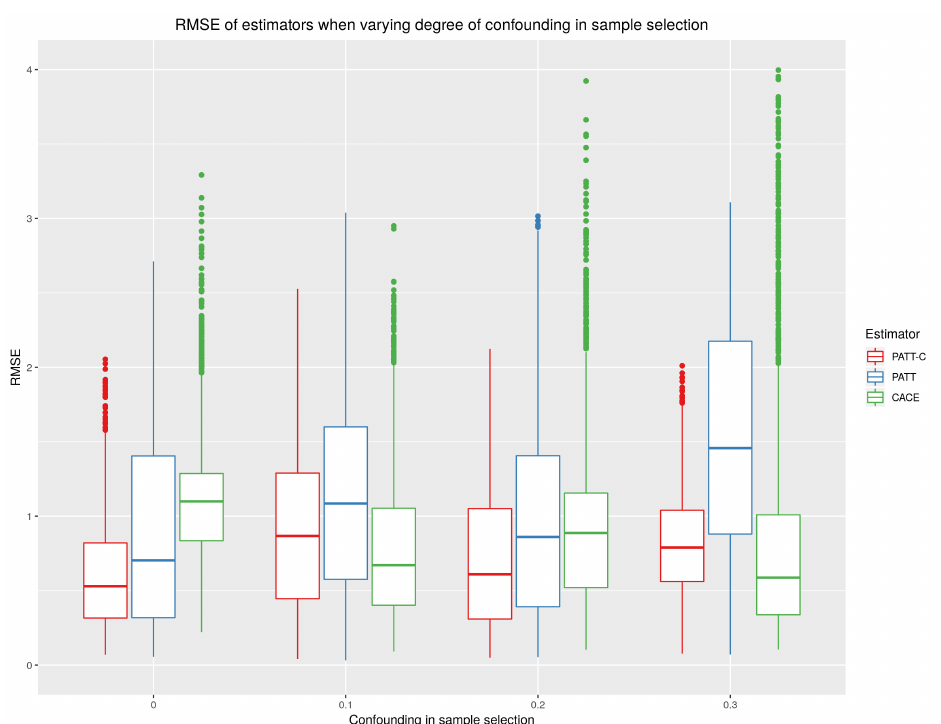
Figure B3: Average RMSE according to degree of confounding in sample